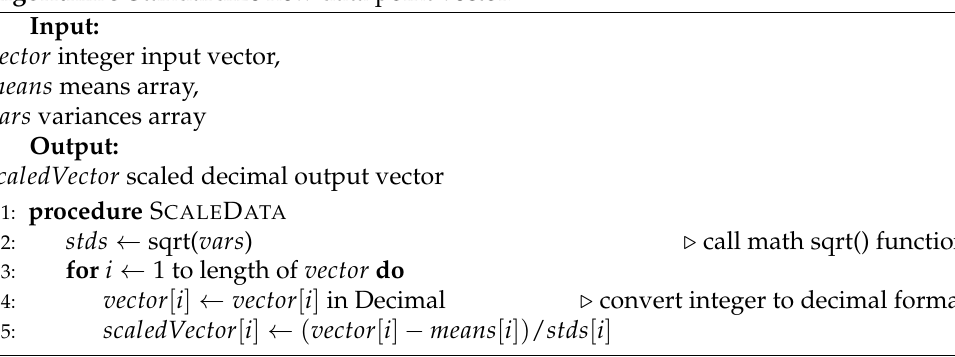
Algorithm 3 Standardize new data point